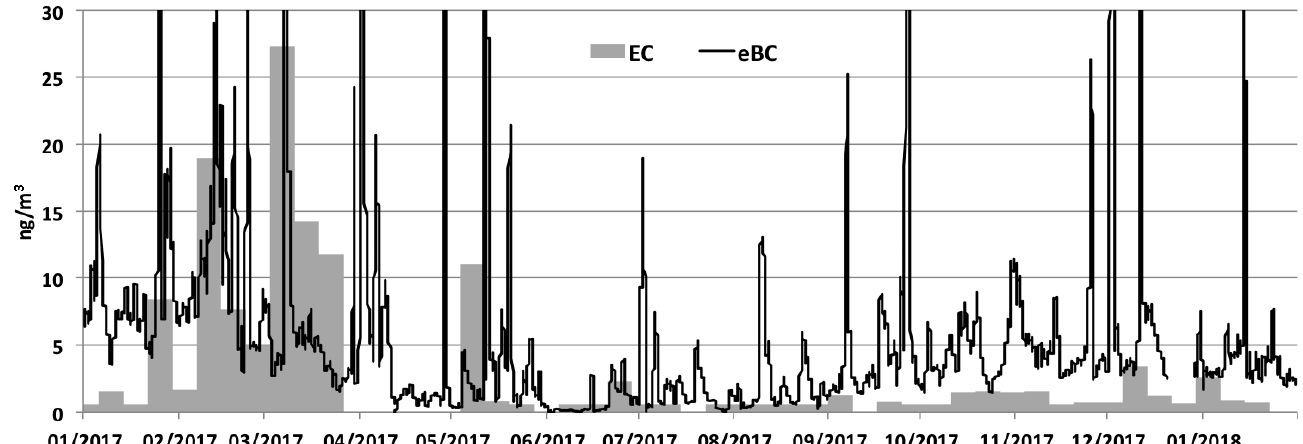
Figure 8. Concentrations of EC and eBC. EC is represented in a grey barplot, showing the lower resolution (8 days) respect to eBC, which is represented by the black line, with a hourly resolution.